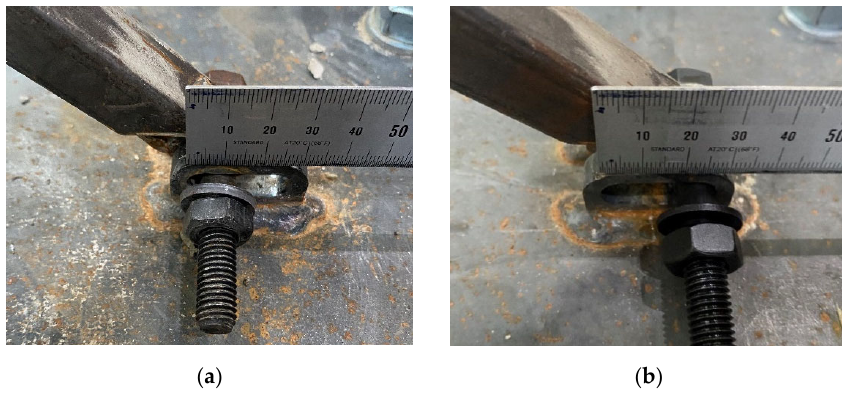
Figure 9. The sliding effect of RSL system: ( a ) Hinge before applying lateral load; ( b ) Sliding bolt reaching the end of the sliding slot.